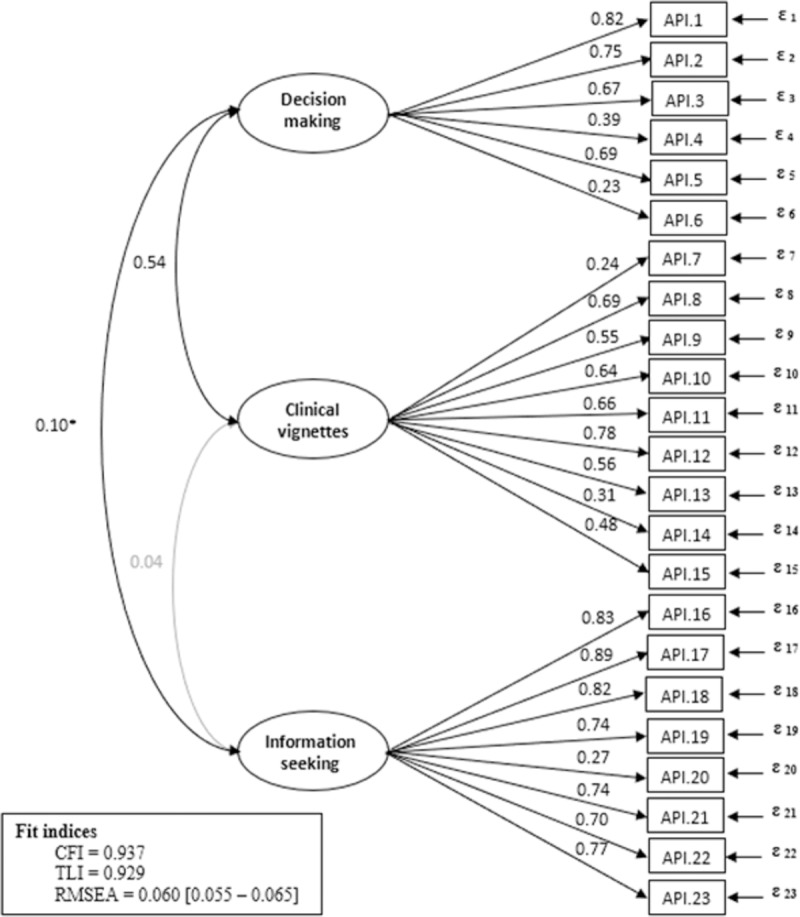
Path diagrams (with standardized coefficients) for the three factor model with fit indices using a confirmatory factor analysis (robust weighted least squares [WLSMV] estimator).Ellipses represent unobserved latent factors, rectangles represent observed variables, single-headed arrows represent the effect of one variable on another (factor loading) and double-headed arrows represent covariance between pairs of variables. Coefficients are all statistically significant with a p-value<0.001, except *p-value = 0.039 and coefficient in grey which is not statistically significant. ε: measurement error df: degree of freedom. CFI: Comparative Fit Index. TLI: Tucker Lewis Index. RMSEA: Root Mean Square Error Approximation.